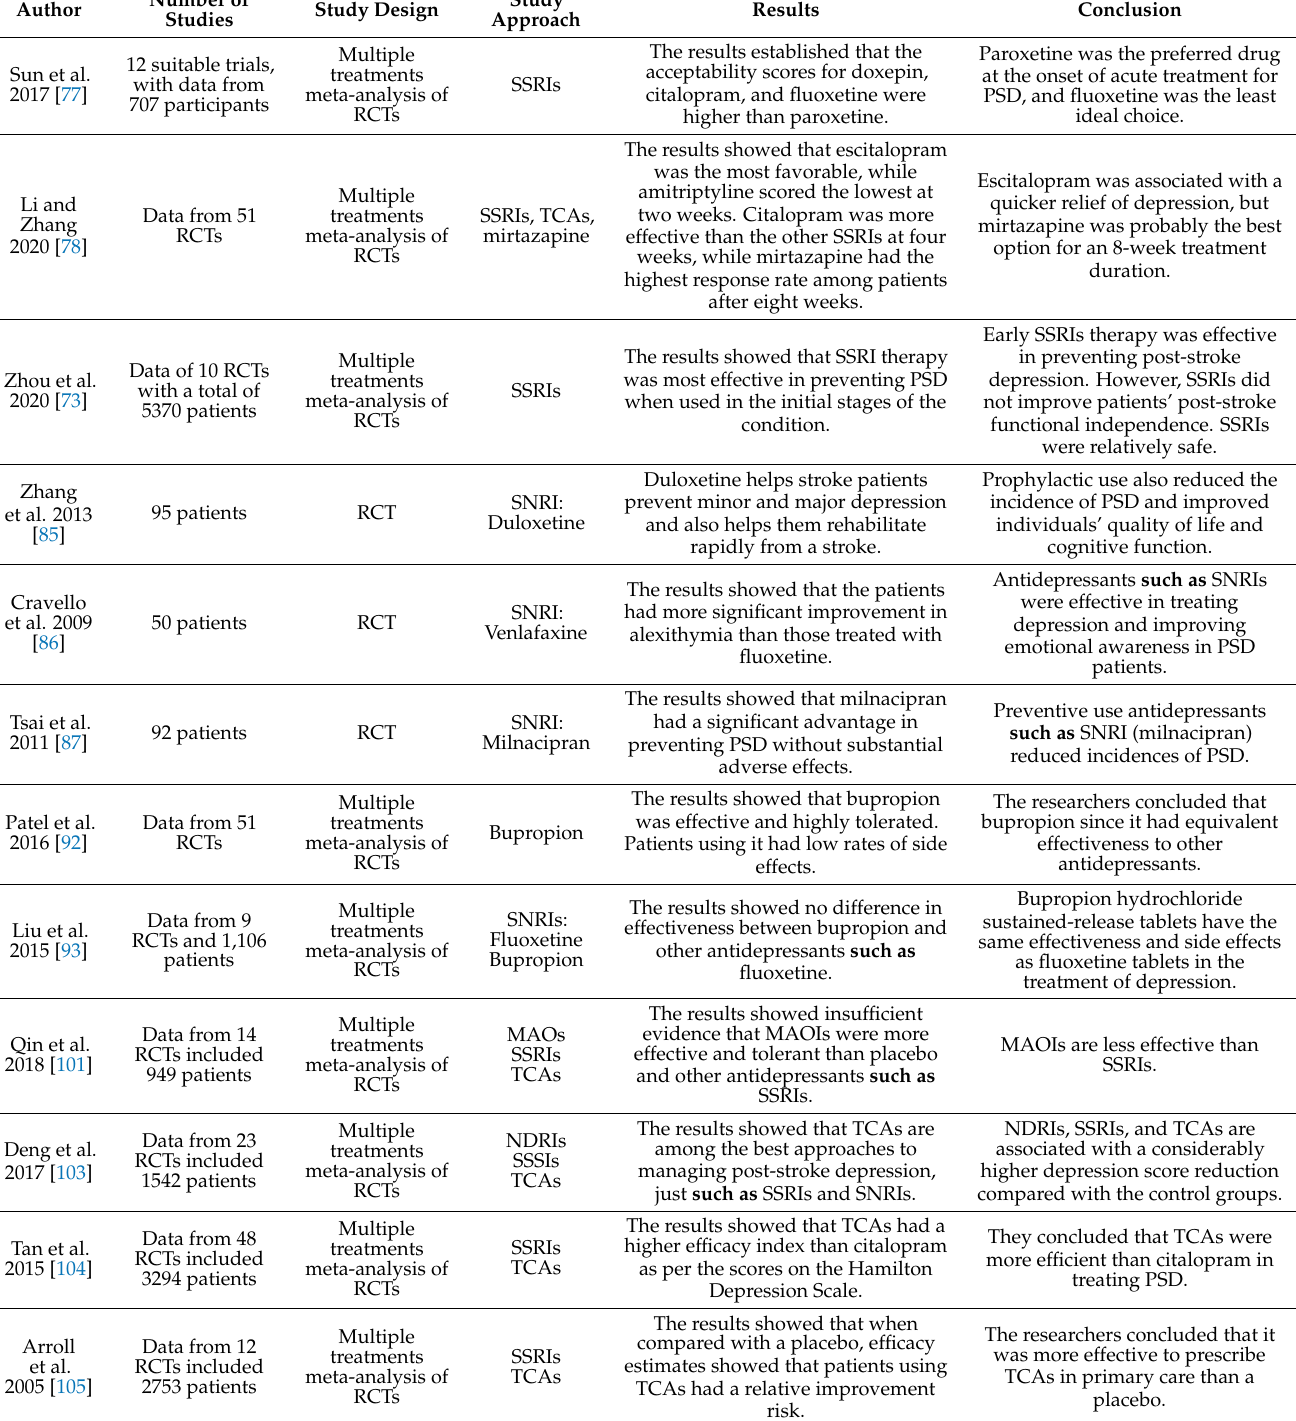
Table 1. The results of individual RCTs and meta-analyses for PSD